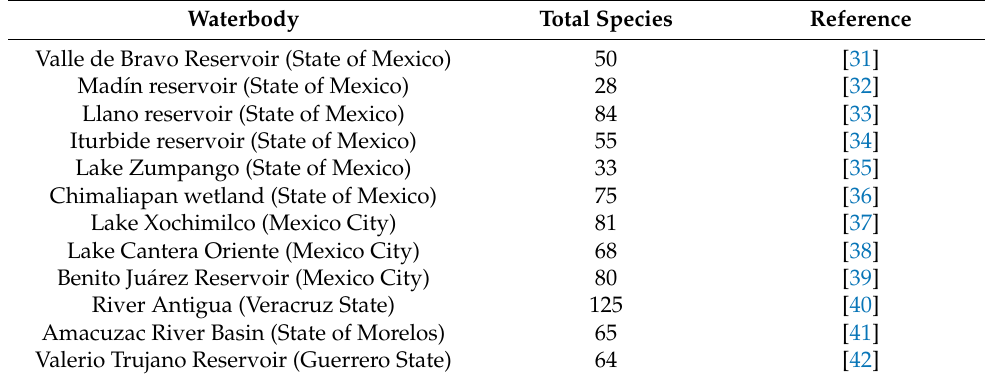
Table 4. The number of rotifer species reported from selected waterbodies through seasonal sampling. Waterbody Total Species